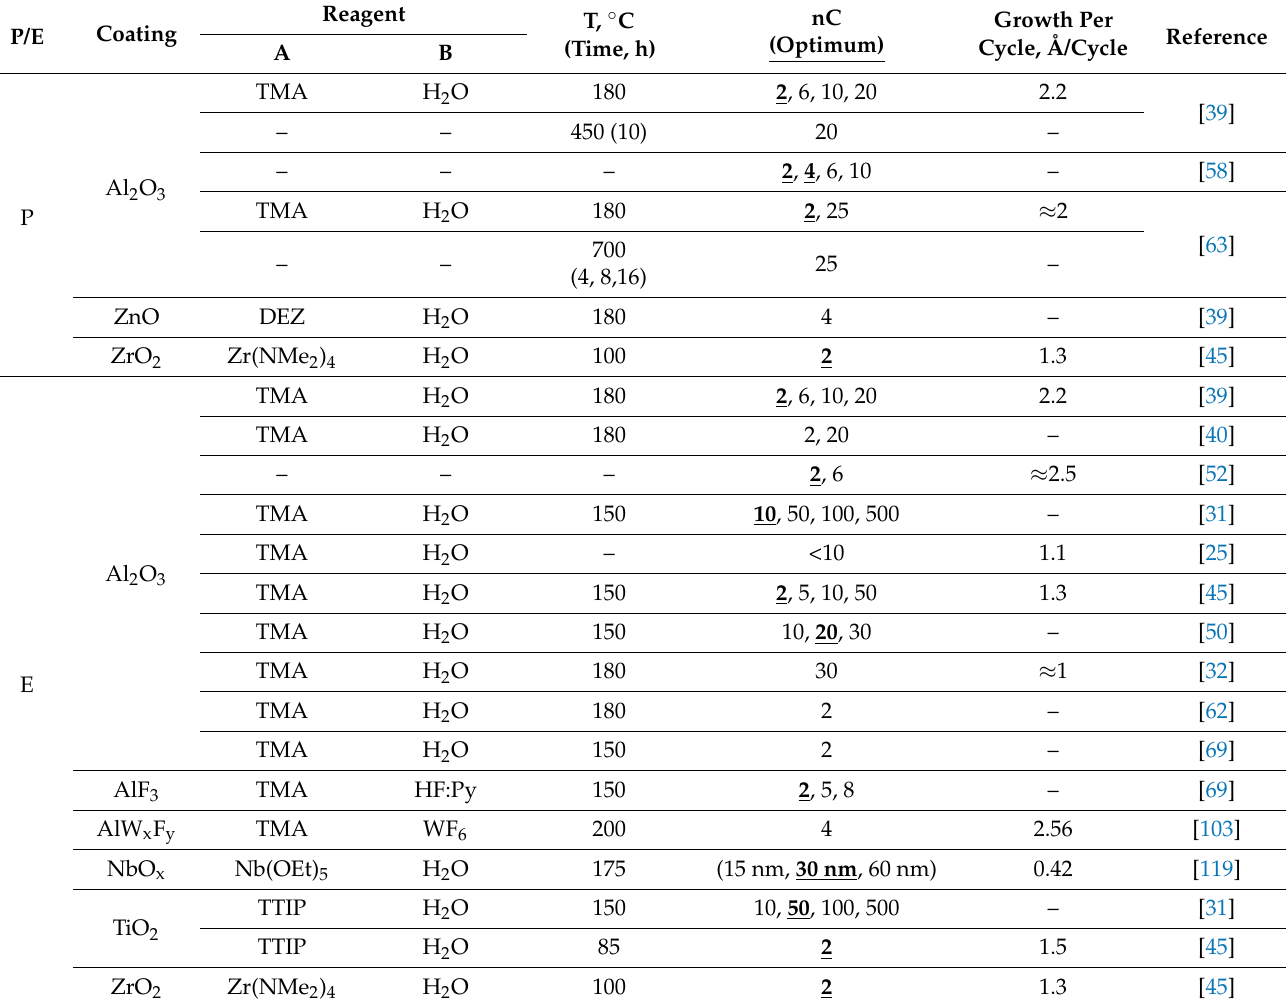
Table 1. Main parameters of LCO (LiCoO 2 )